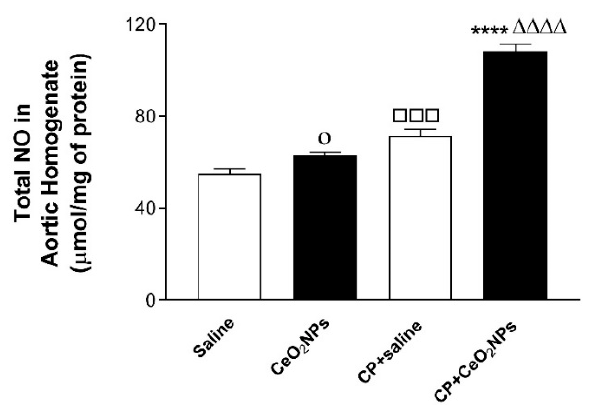
Figure 4. Total nitric oxide (NO) concentration in aortic homogenates of rats intratracheally instilled with either saline ( n = 5) or CeO2 NPs ( n = 5) with ( n = 5) or without ( n = 5) CP administration. **** P < 0.0001 compared with CP + saline-treated group. ΔΔΔΔ P < 0.0001 compared with CeO 2 NPs-treated group. □□□ P < 0.001 compared with saline-treated group. ο P < 0.05 compared with saline-treated group. Data are mean ± SEM.